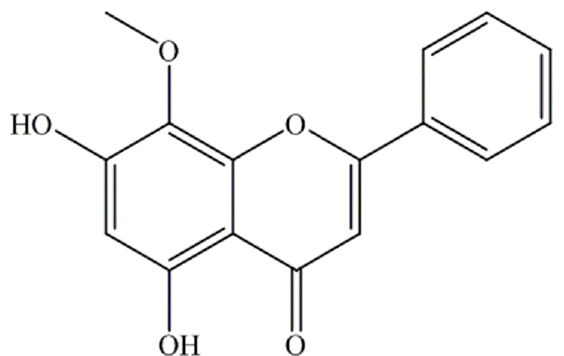
Figure 1. Chemical structure of